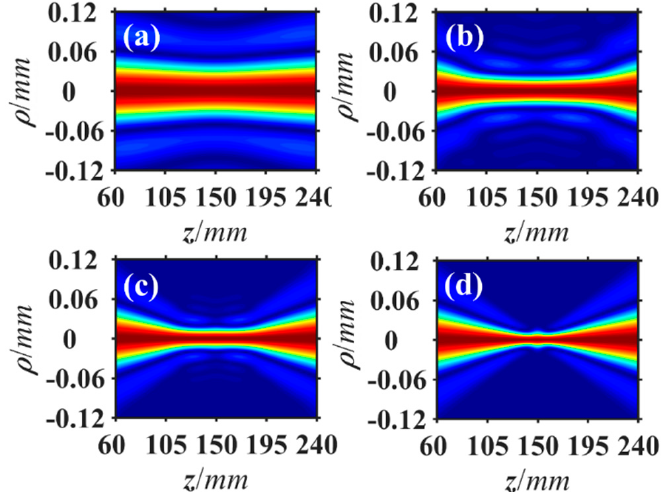
Figure 5. Modulus of the spectral degree of coherence (SDOC) | μ ( ρ ,0)| of an apertured BGCSM beam focused by a thin lens in the ρ – z plane for different a, with β = 2.5 and δ 0 = 0.2 mm. ( a ) a = 0.5; ( b ) a = 1; ( c ) a = 1.5; and ( d ) without aperture.